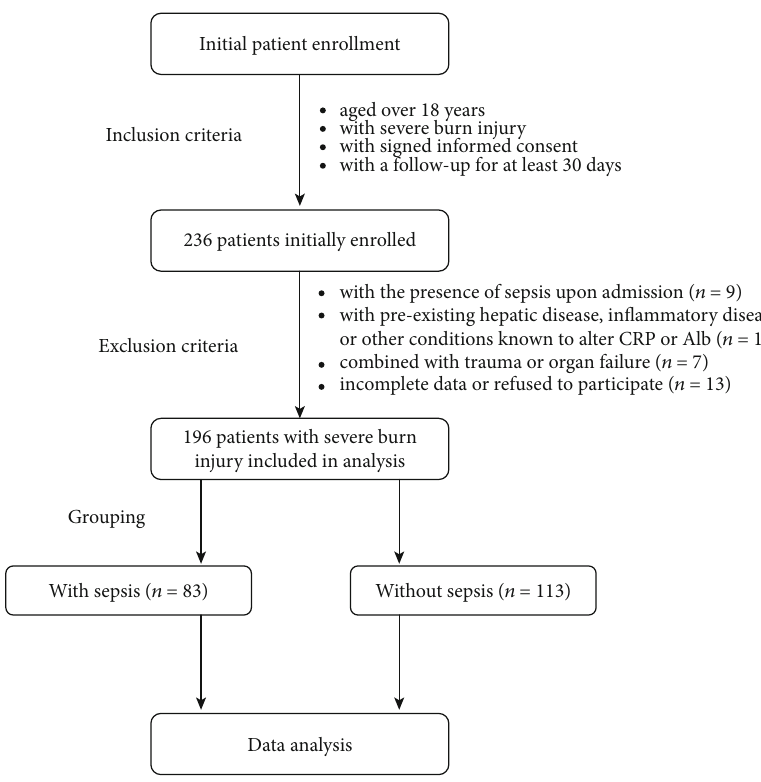
Figure 1: Flow chart. CRP: C-reactive protein; Alb: albumin. Table 1: Clinical and therapeutic parameters in severe burns admitted to the intensive care unit